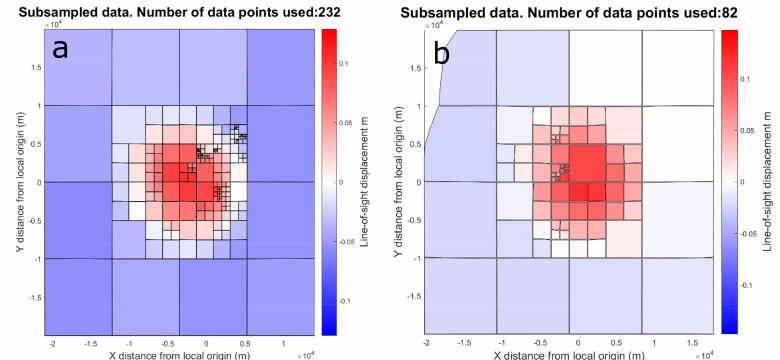
Figure A2. Subsampled used for the InSAR modeling. ( a ) Ascending subsampled (quadtree = 2 × 10 − 4 ); ( b ) descending subsampled data (quadtree = 2.5 × 10 − 4